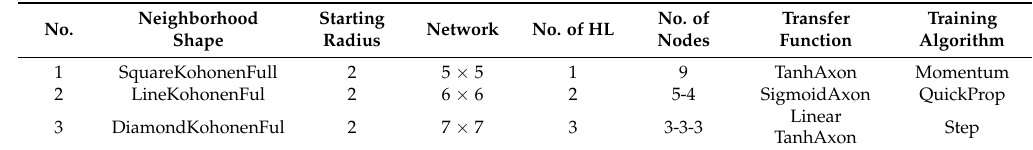
Table 4. Different SOFM models.